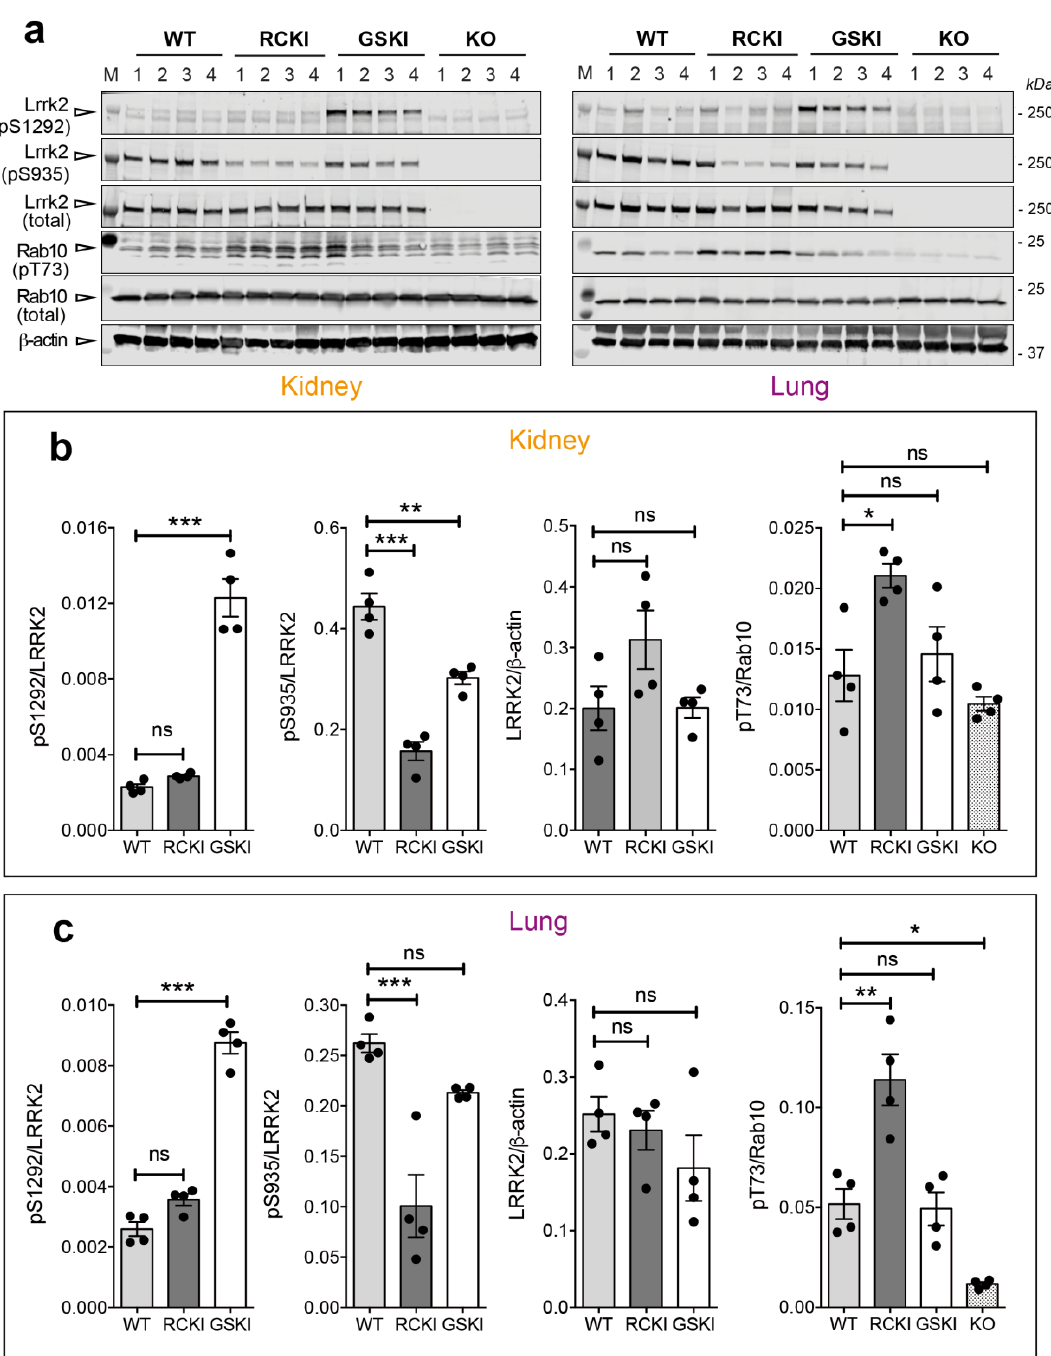
Figure 3. Differences in Ser935-Lrrk2, Ser1292-Lrrk2 and Thr73-Rab10 phosphorylations and total Lrrk2 between G2019S and R1441C knockin lungs and kidneys. ( a ) Representative western blots of WT, RCKI, GSKI, and knockout (KO) lysates from kidney and lung of 12-months-old animals showing Lrrk2 and Rab10 phosphorylation levels. ( b , c ) Quantifications of Ser935, Ser1292 phosphorylations (phospho/total Lrrk2), total Lrrk2 (Lrrk2/ β -actin), and Thr73-Rab10 phosphorylation (phospho/total Rab10) in kidneys and lungs respectively of WT, RCKI, GSKI mice. Each dot in the bar graph represents one animal. Data are shown as mean ± SEM; One-way ANOVA with Dunnett post-hoc test (ns: not significant; * p < 0.05; ** p < 0.01; *** p < 0.001). To understand whether the lack of phospho-Ser1292 activation in RCKI mice reflects a general inability of this mutation to manifest a similar gain of kinase function observed in cell models [7], we